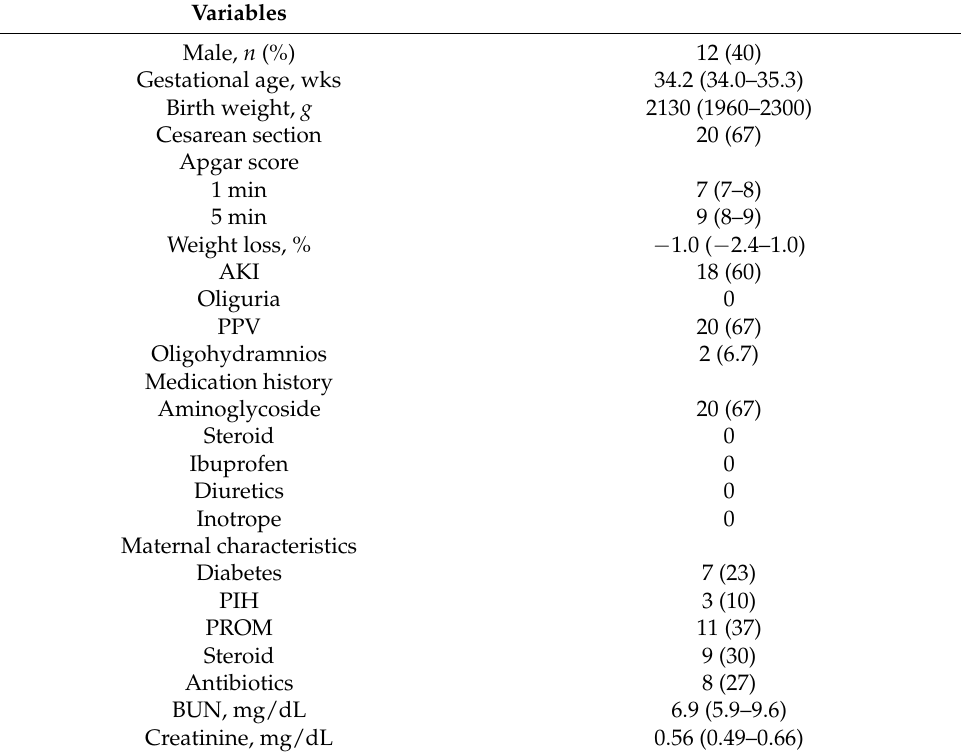
Table 1. Demographic and clinical characteristics of study group.